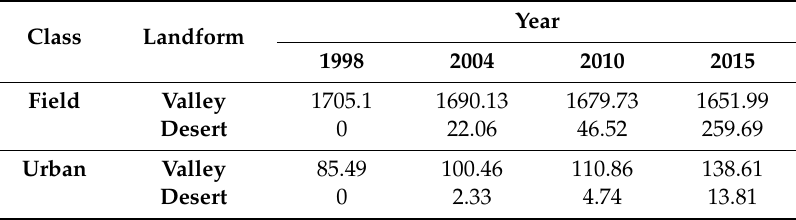
Table 5. Evolution in urban and field classes across the di ff erent landforms from 1998 to 2015 (km 2